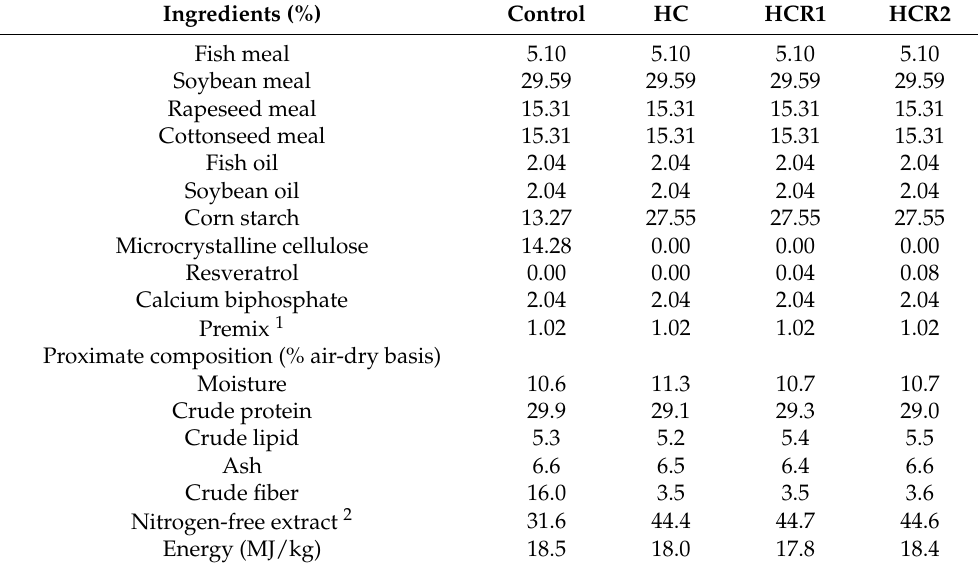
Table 1. Formulation and proximate composition of the experimental diets. Ingredients